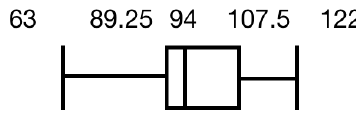
Figure 7: Desirability Control Scale.